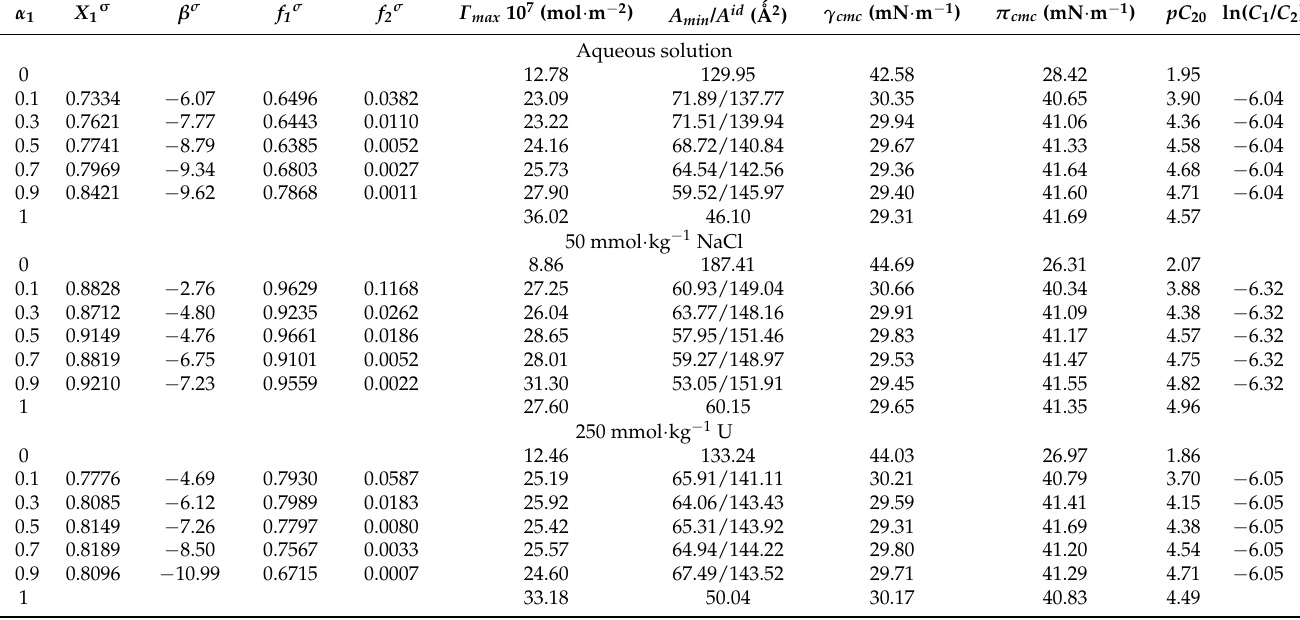
Table 1. Different interfacial parameters for IMP+TX-100 mixture in several media at 298.15 K a